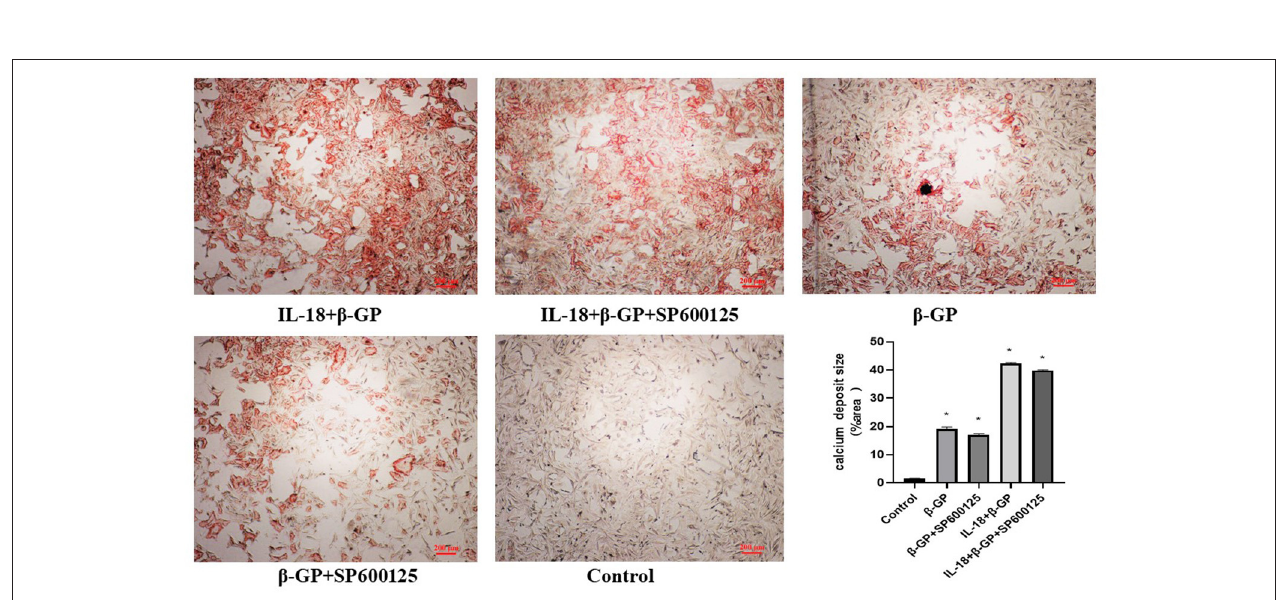
FIGURE 14 | Alizarin red staining of VSMCs. Effect of JNK pathway on IL-18-induced calcium deposition of rat VSMCs. Rat VSMCs were pre-incubated with JNK inhibitor SP600125 (10 µ mol/L) for 30min, and then treated with β -GP (10 mmol/L) or IL-18 (100ng/ml) + β -GP (10 mmol/L) for 14 days, respectively. And then the VSMCs were stained with Alizarin red. The experiment was repeated 3 times independently. * P < 0.01 vs. control group. β -GP, β -glycerol phosphate.